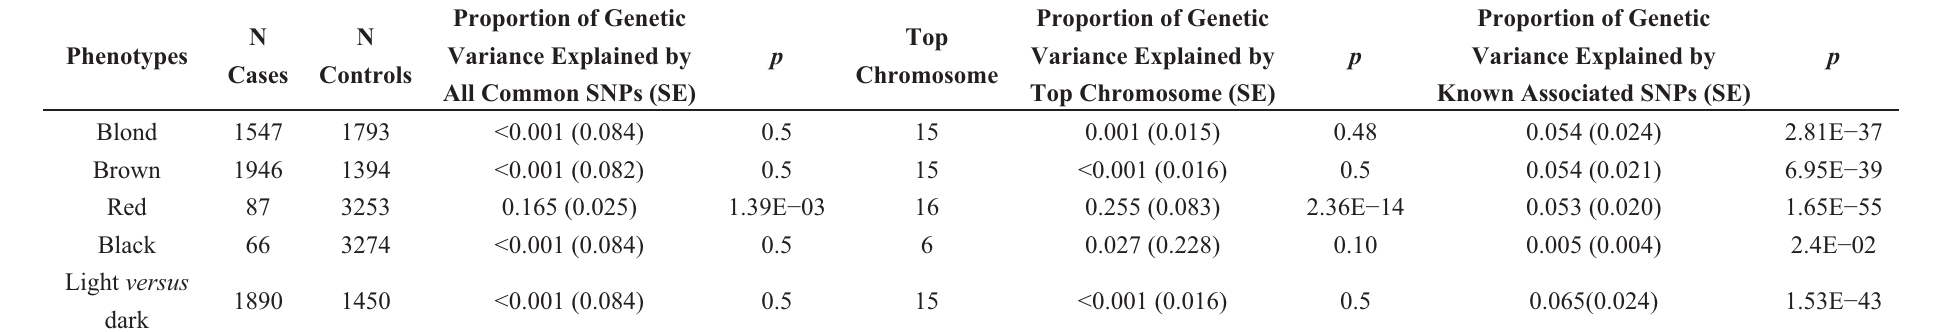
Table 4. The explained genetic variance of the hair color liability scale for autosomal common SNPs in GCTA including the three Dutch PCs as